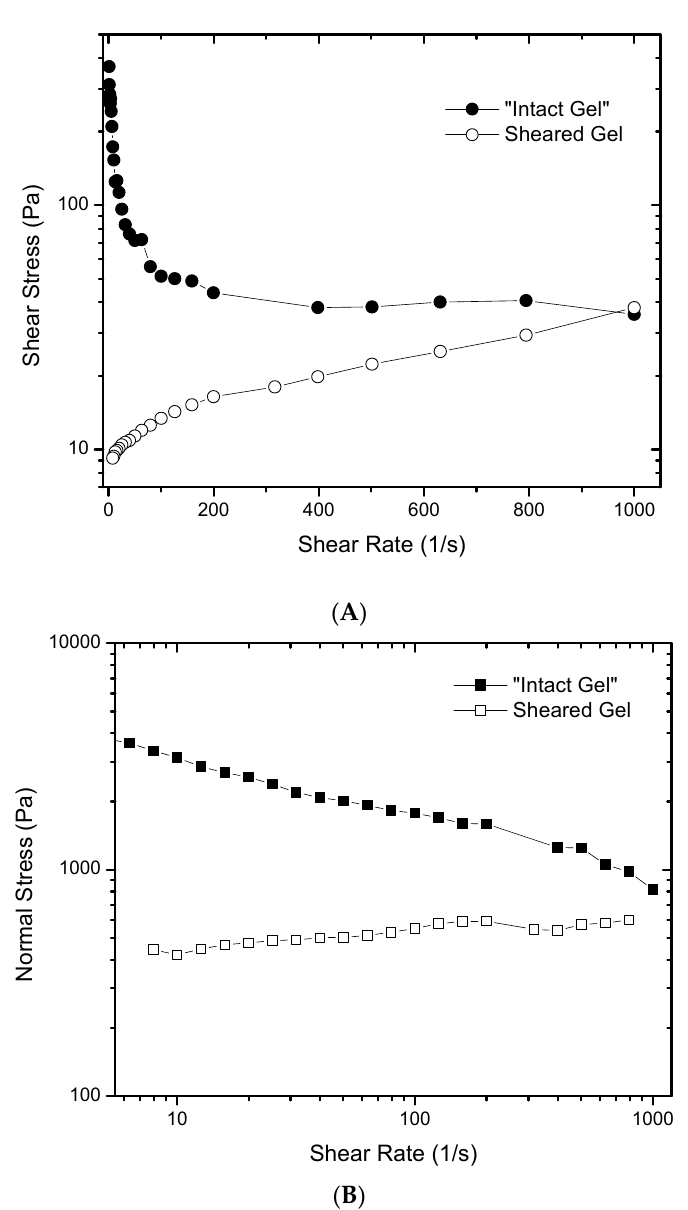
Figure 4. “Intact” and sheared gels: ( A ) shear stress versus shear rate of 6% gels. A typical curve of shear thinning fluid is only observed for the sheared gel (empty circle marks); ( B ) first normal stress versus shear rate of 6% gels. Filled squares show the decrease in normal stress of the “intact” gel at different shear rates. Empty squares show no variation of normal stress at different shear rates.